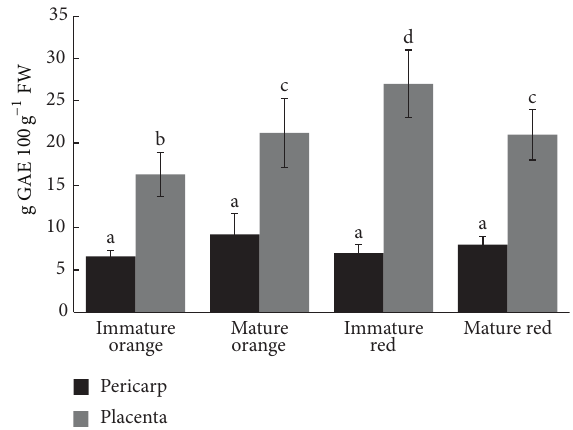
Table 2: TEAC antioxidant capacity of C. chinense ethanolic extracts.